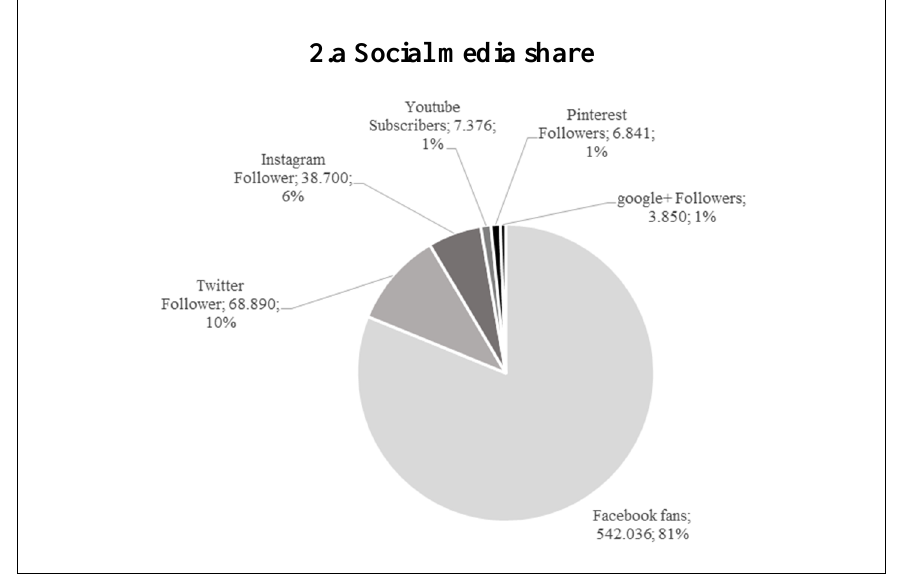
Figure 2: The Social Media Communities of Italian